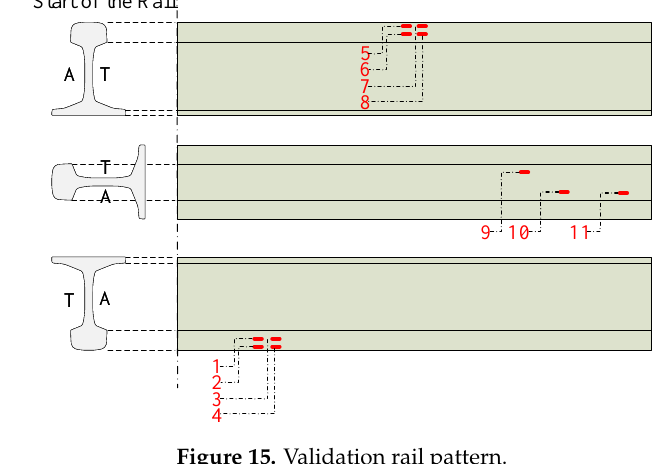
Figure 15. Validation rail pattern.